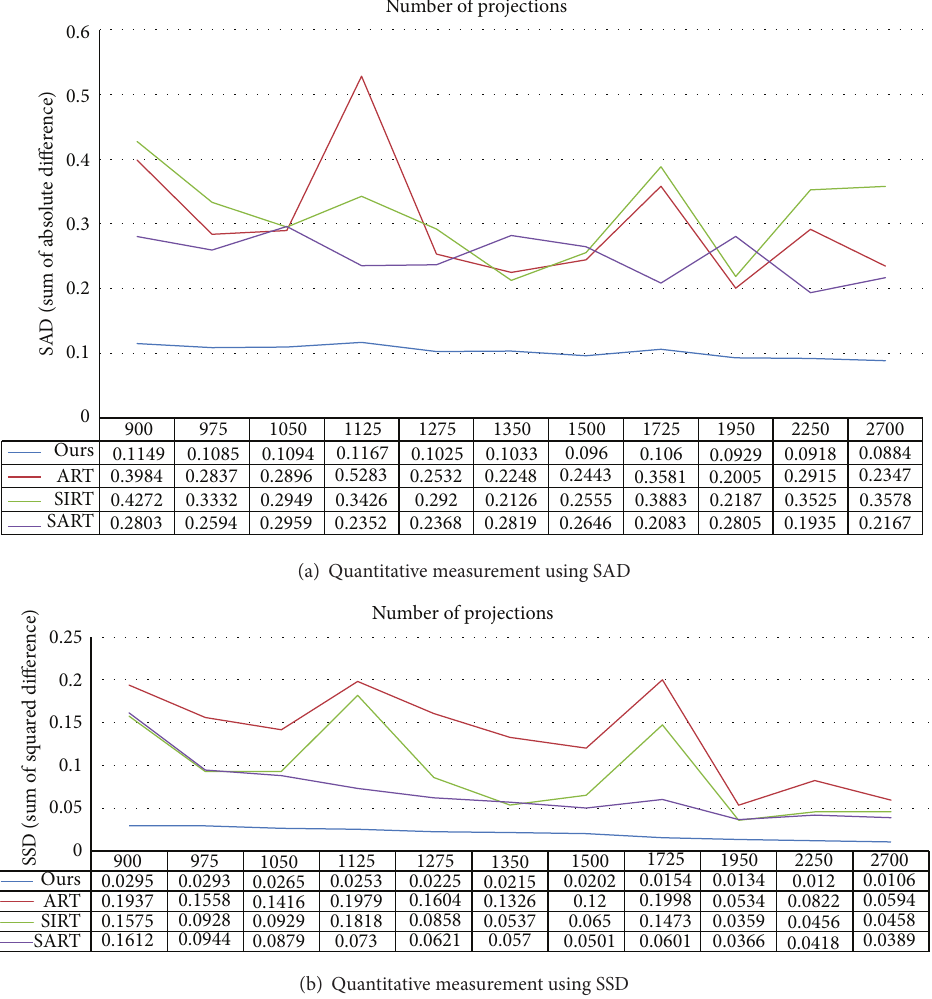
Figure 3: Quantitative comparison of previous approaches and our proposed approach using SAD and SSA by changing the number of angular projections from 900 to